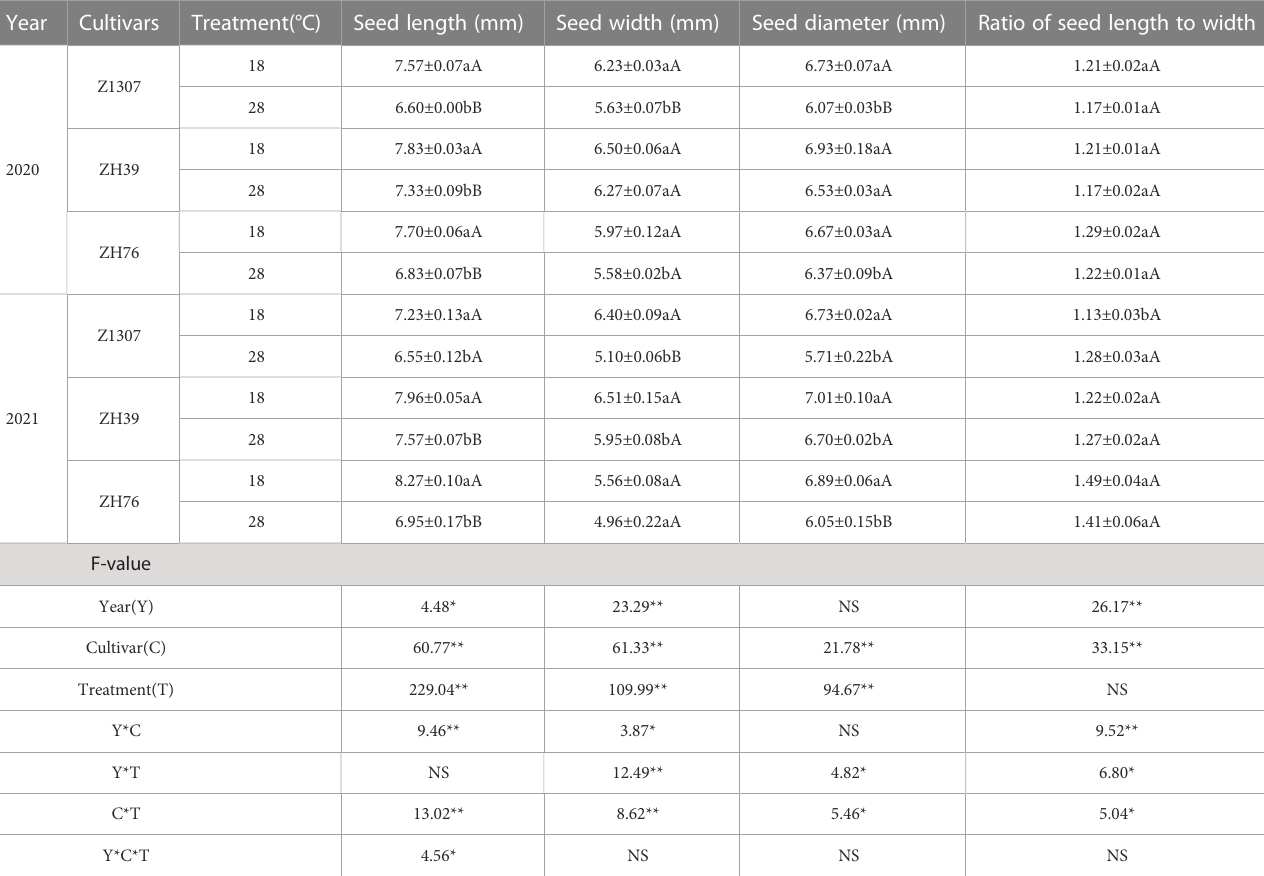
TABLE 2 Effects of different night temperature on seed size of